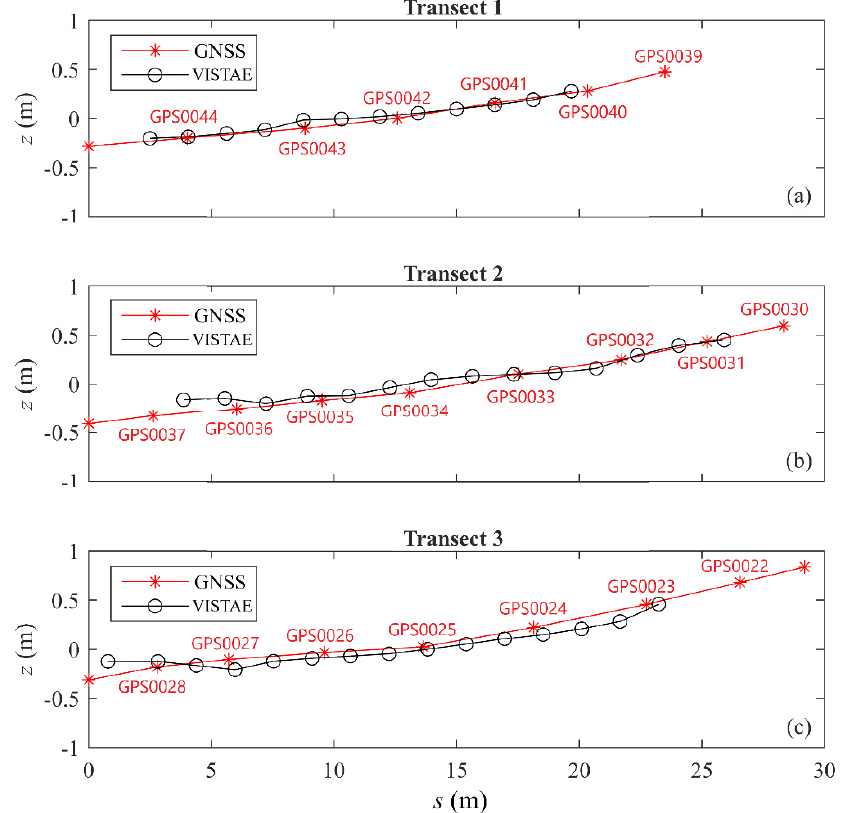
Figure 9. Comparison between transects (see Figure 8a for planimetric position) measured by the GNSS (red lines) and extrapolated by the low-cost camera VISTAE (black lines). The red numbers indicate the same GPS points measured in Figure 8a.